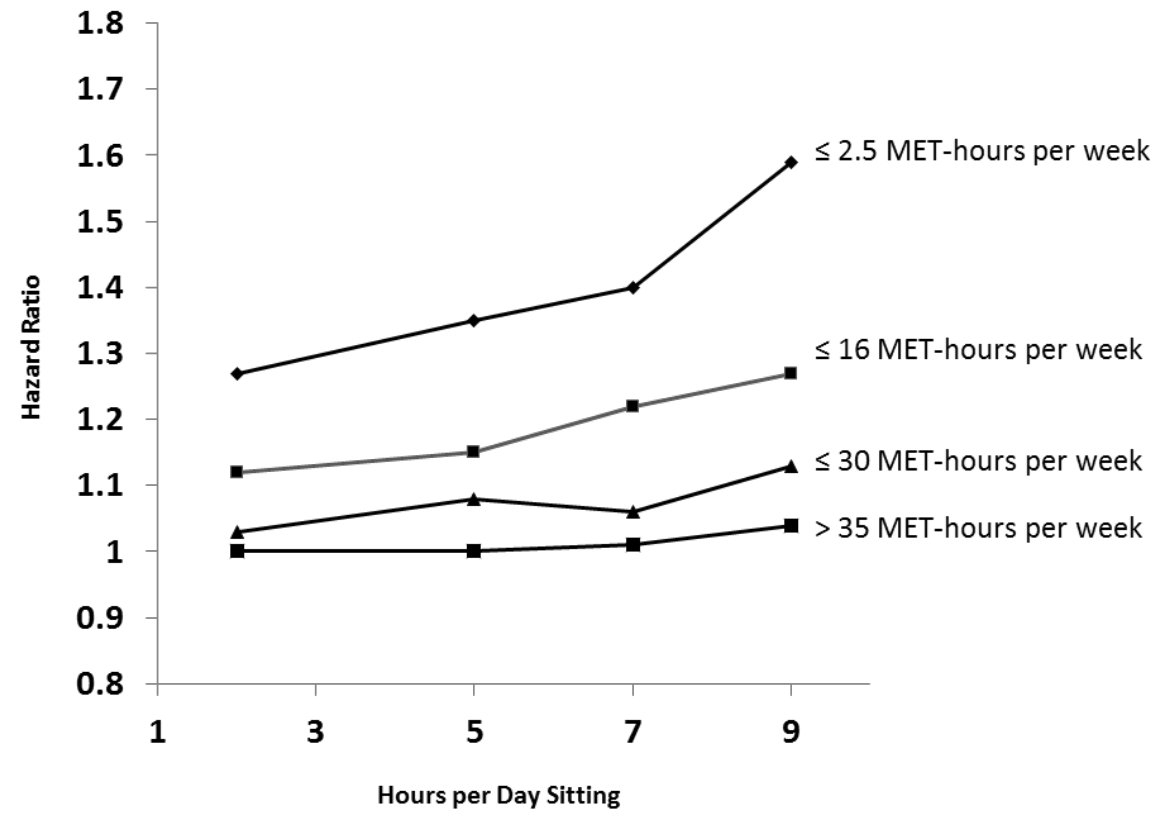
Figure F2-2. Relationship Between Sitting and All-Cause Mortality, Stratified by Amount of Moderate- to-Vigorous Physical